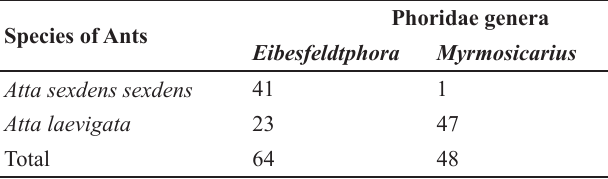
Table 1. Number of individuals of Eibesfeldtphora and Myrmosicarius (Diptera: Phoridae) in different species of Atta , in Cruz das Almas- BA, Brazil.